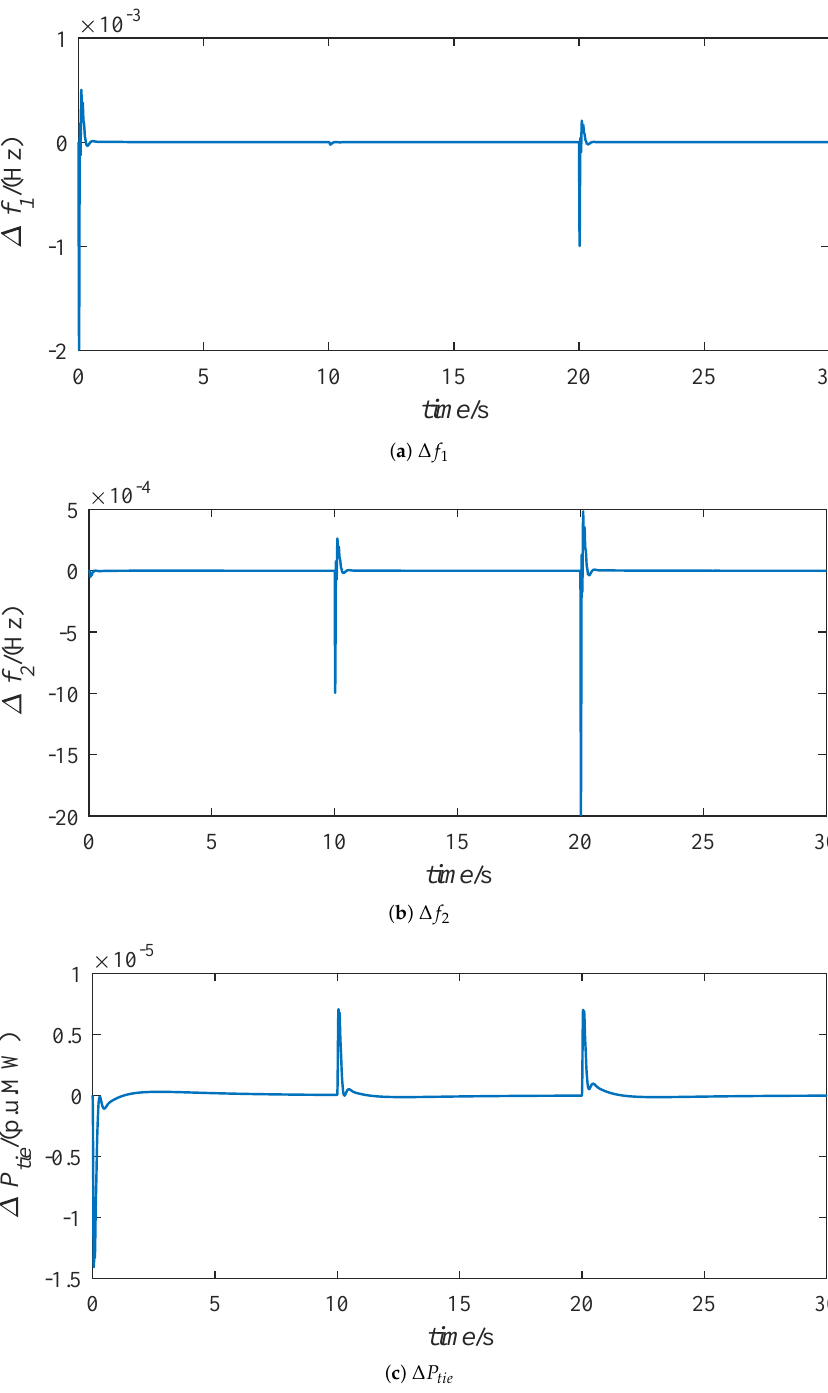
Figure 10. Dynamic response with different